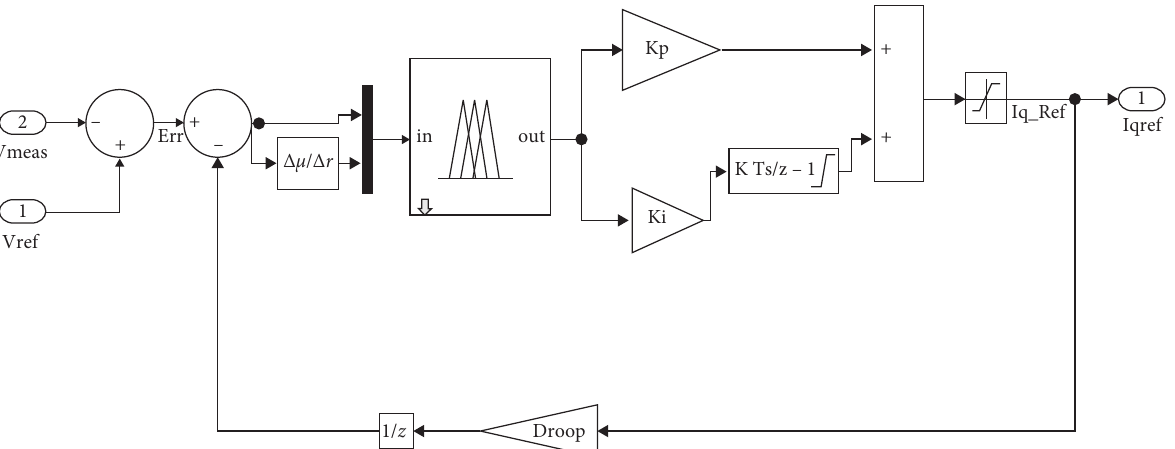
Figure 4: Structure of fuzzy-PI controller.